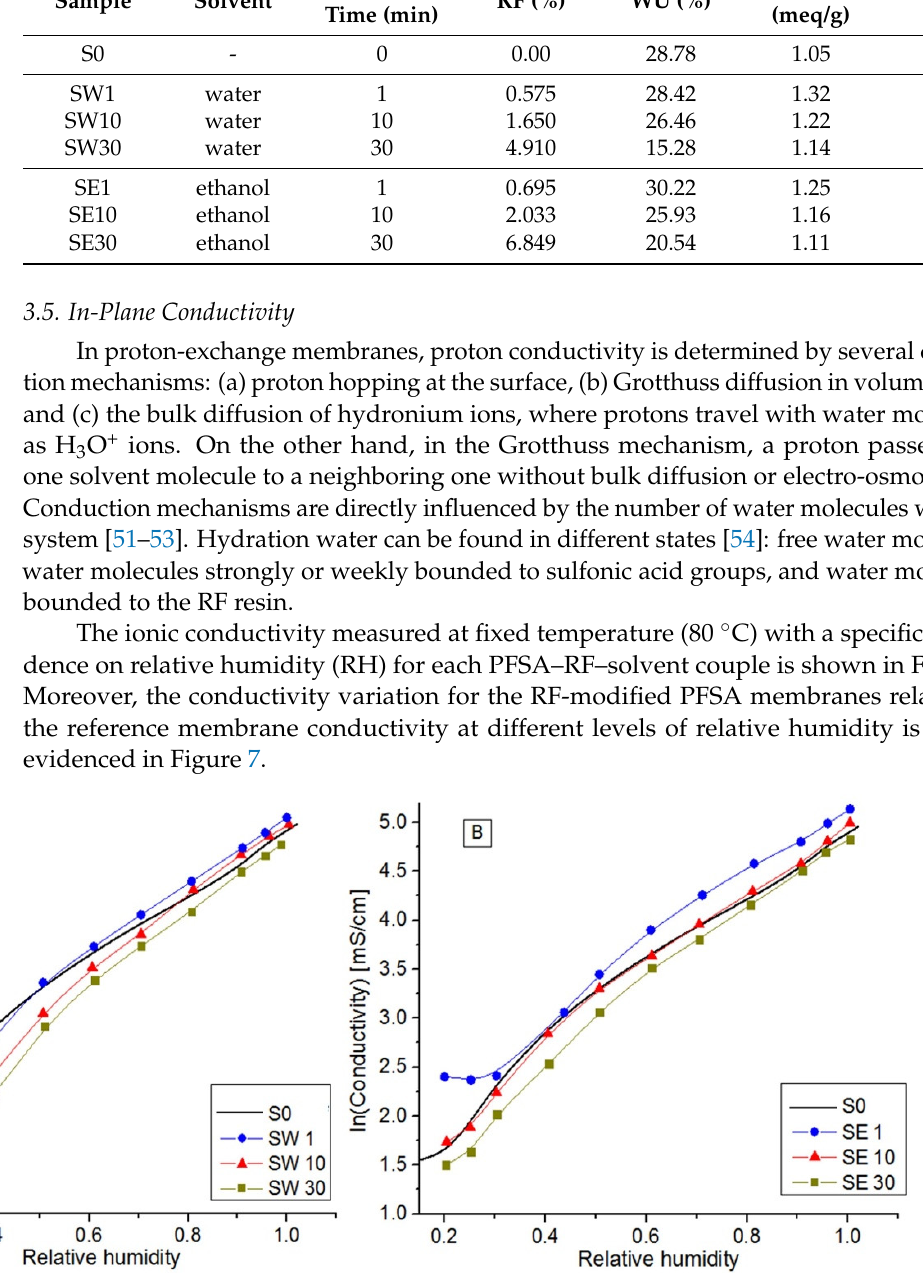
Figure 7. Conductivity variation for the RF-modified PFSA membranes relative to the reference membrane conductivity at different levels of relative humidity.